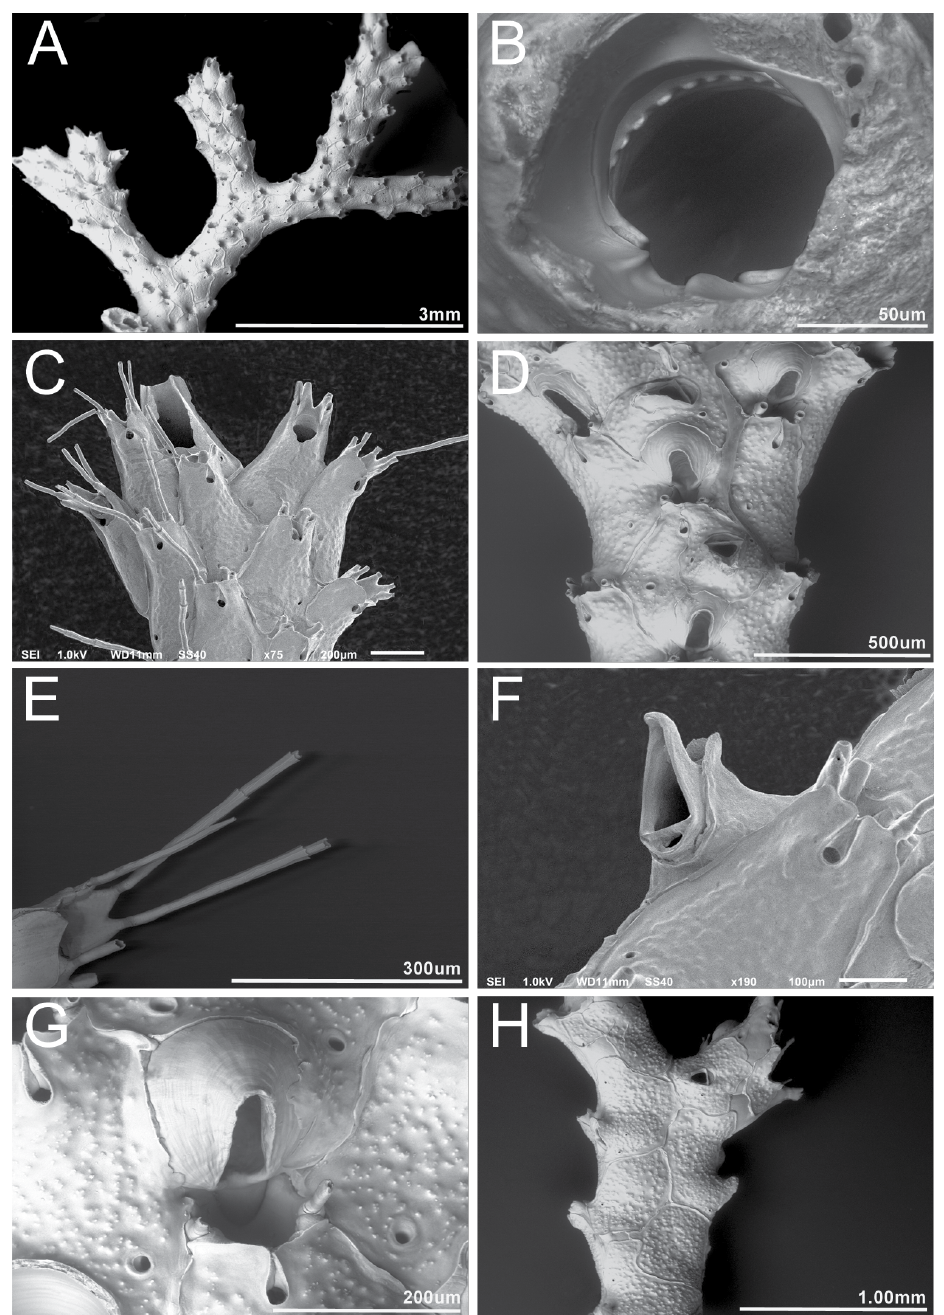
Fig. 5. Schizoretepora solanderia (Risso, 1826), Menorca Channel (A–B, D, G–H: MZB 2014-1471; C, E–F: MZB 2014-1486). A . Colony view. B . Detail of aperture. C . Growing margin with autozooids showing up to six spines. D . Older ovicellate autozooids with giant vicarious avicularia. E . Detail of articulated and carenated spines. F . Marginal avicularia showing nested piling of cystids. G . Details of ovicell. H . Abfrontal view with